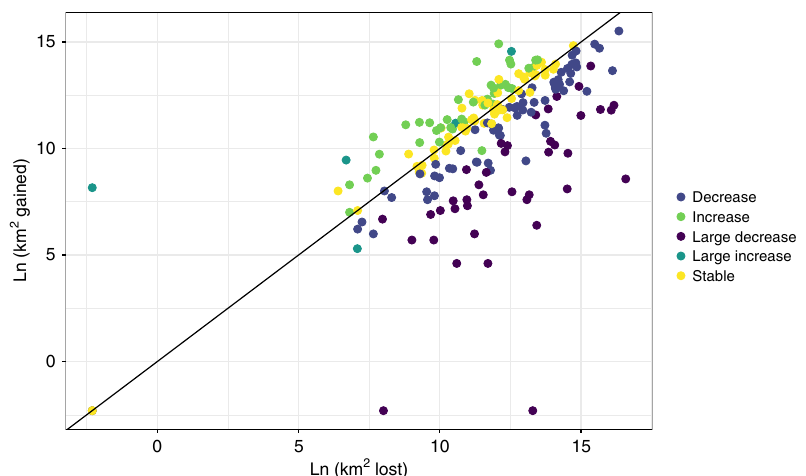
Fig. 1 Scatterplot showing the relationship between increase and decrease in the range of each species. Classes refer to the percentage range change with respect to the 1970s: large decrease (>50%), moderate decrease (between 49 and 5%), stable (within 5%), moderate increase (between 5 and 49%) and large increase